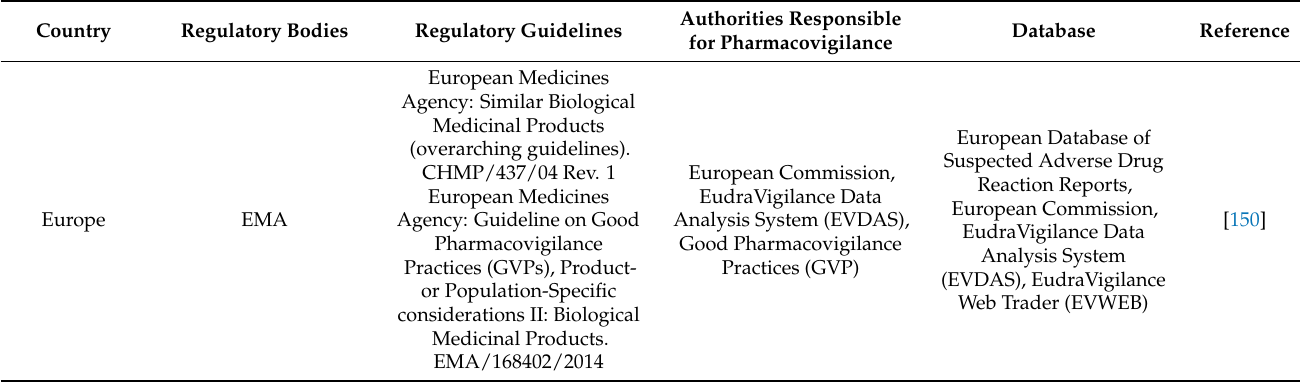
Table 2. Comparison between the guidelines of various